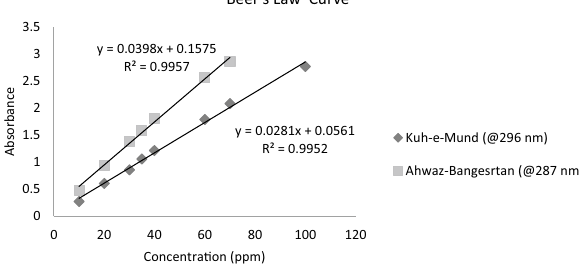
Fig. 2 Standard concentration curve for Ahwaz-Bangestan and Kuh-